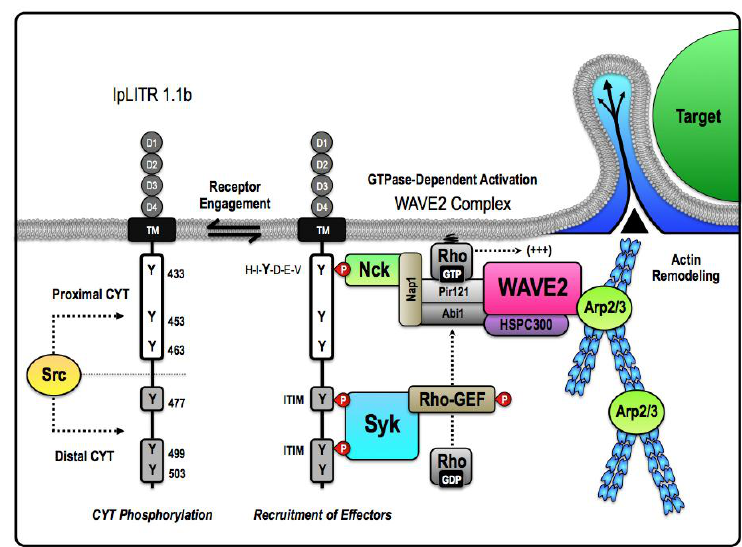
Figure 2. Proposed mechanism for an ITAM-independent target acquisition and engulfment pathway facilitated by pLITR 1.1b. The unique short-circuited version of phagocytosis exhibited by IpLITR 1.1b-expressing cells likely requires that the proximal and distal regions of the IpLITR 1.1b CYT differentially participate in the recruitment and activation of select phagocytic effectors. Our results suggest that IpLITR 1.1b-mediated regulation of the actin polymerization machinery is dependent upon the catalytic activity of the Src and spleen tyrosine kinase (Syk) families of intracellular kinases [57]. We hypothesize that Src serves to place IpLITR 1.1b in a primed state that facilitates basal or constitutive coupling of IpLITR 1.1b to the minimal intracellular machinery required for target acquisition and phagocytic cup extension. In this model, the cytosolic adaptor non-catalytic region of tyrosine kinase adaptor protein 1 (Nck) is recruited to the consensus interaction motif H-I-Y-D-E-V located at Y 433 in the proximal CYT region of IpLITR 1.1b. Nck has been shown to associate with the WAVE2 complex; a highly conserved pentameric heterocomplex that dynamically regulates Arp2/3-dependent actin polymerization [104]. Importantly, in mammalian cells, WAVE2 is expressed ubiquitously and found as a complex with four other proteins: Pir121, Nap1, Abi-1, and HSPC300 [104]. The mature WAVE2 complex is basally inactive and directly interacts with the SH3 domain of Nck through Nap1 [103,105]. Activation of the WAVE2 complex requires state-specific phosphorylation as well as interactions with GTP-bound Rho superfamily proteins, most commonly Rac [106]. As a result, we propose that the assembly of the Nck-WAVE2 complex within the proximal CYT region of IpLITR 1.1b could be coupled to recruitment of a stimulatory Rho-GEF within the distal CYT region. In particular, the spacing of the tyrosines in IpLITR 1.1b suggest that Syk could be recruited to two tandem ITIM motifs at Y 477 and Y 499 in the distal CYT region. Based on comparisons with other phagocytic receptors, we suspect that activation of the cytosolic Rho-GEF could be Syk-dependent. Syk activation of the Rho-GEF would provide the necessary catalyst for rapid actin-driven membrane protrusions via the WAVE2 complex. Together, this mechanism would encompass the minimal machinery required for PI3K-independent target capture pathway by IpLITR